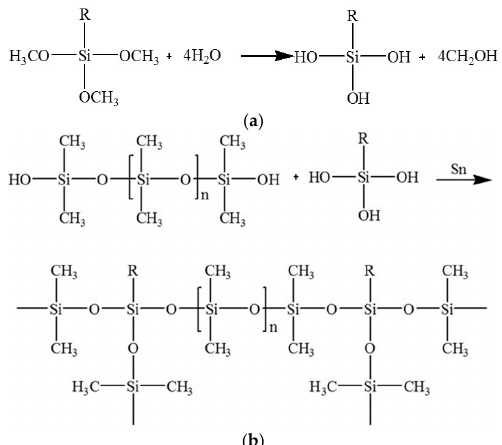
Figure 4. Chemical reaction principle of waterborne silicone. ( a ) The curing agent hydrolysis reaction; ( b ) Crosslinking reaction between silanol and silicone.